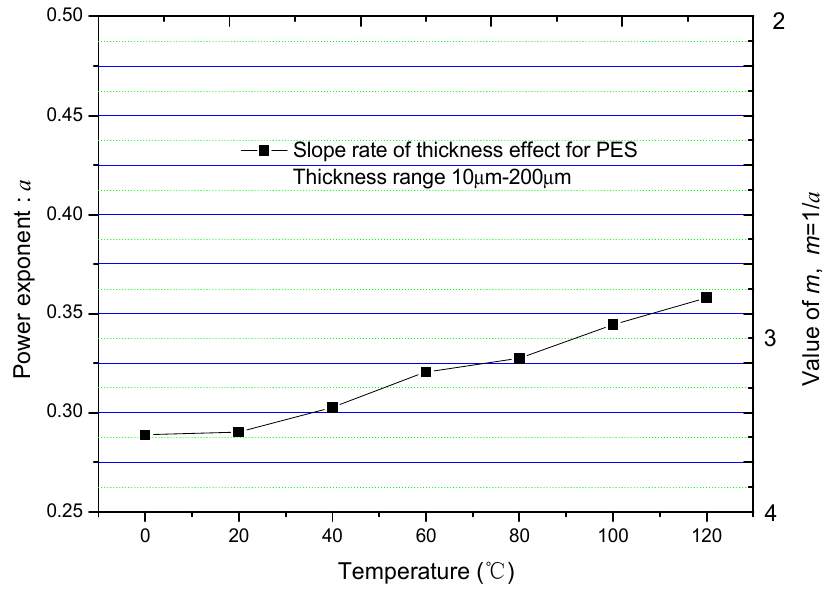
Figure 16. The dependence of a on temperature.